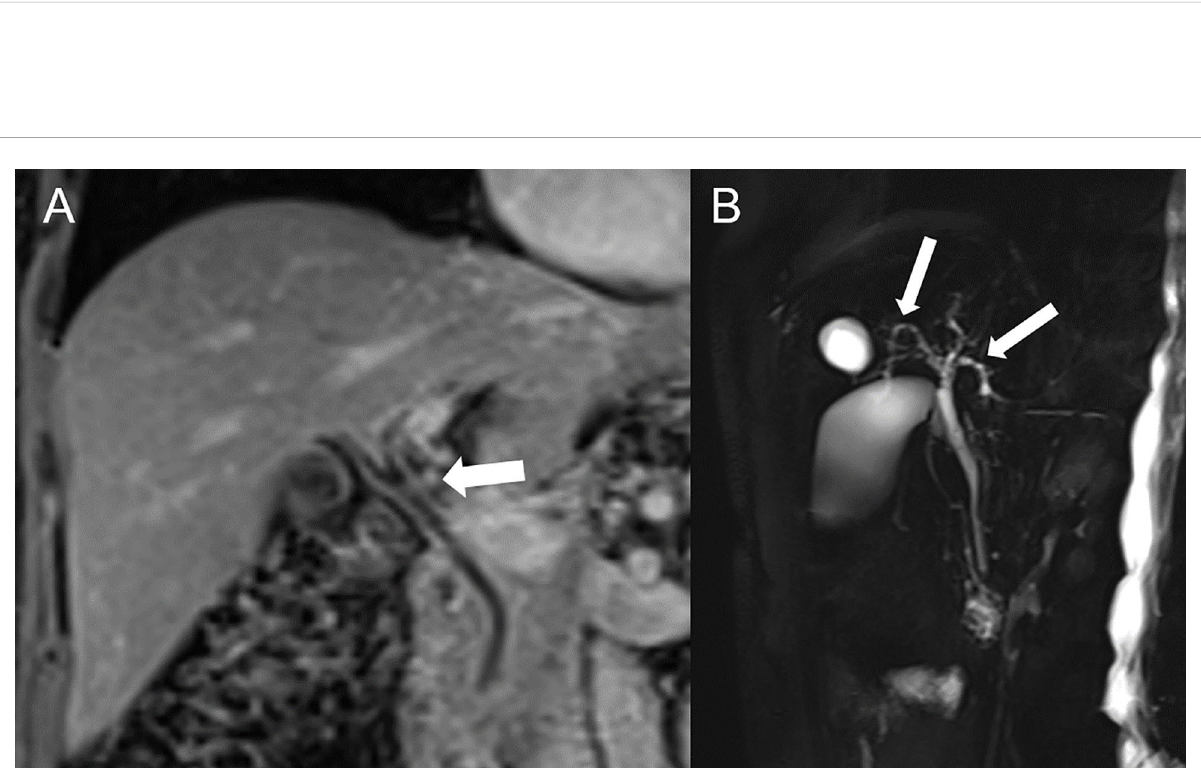
FIGURE 2 Immune-related hepatitis and cholangitis in a 73-year-old female with metastatic melanoma of the tibia on nivolumab (anti-PD-1) and ipilimumab (anti-CTLA-4) who developed grade 3 hepatitis. (A) Contrast-enhanced MRI in coronal view show hyperhemic and slightly thickened bile duct walls (arrow) and (B) MR cholangiopancreatography demonstrate bile ducts irregularities (arrows) compatible with immune-mediated cholangitis.